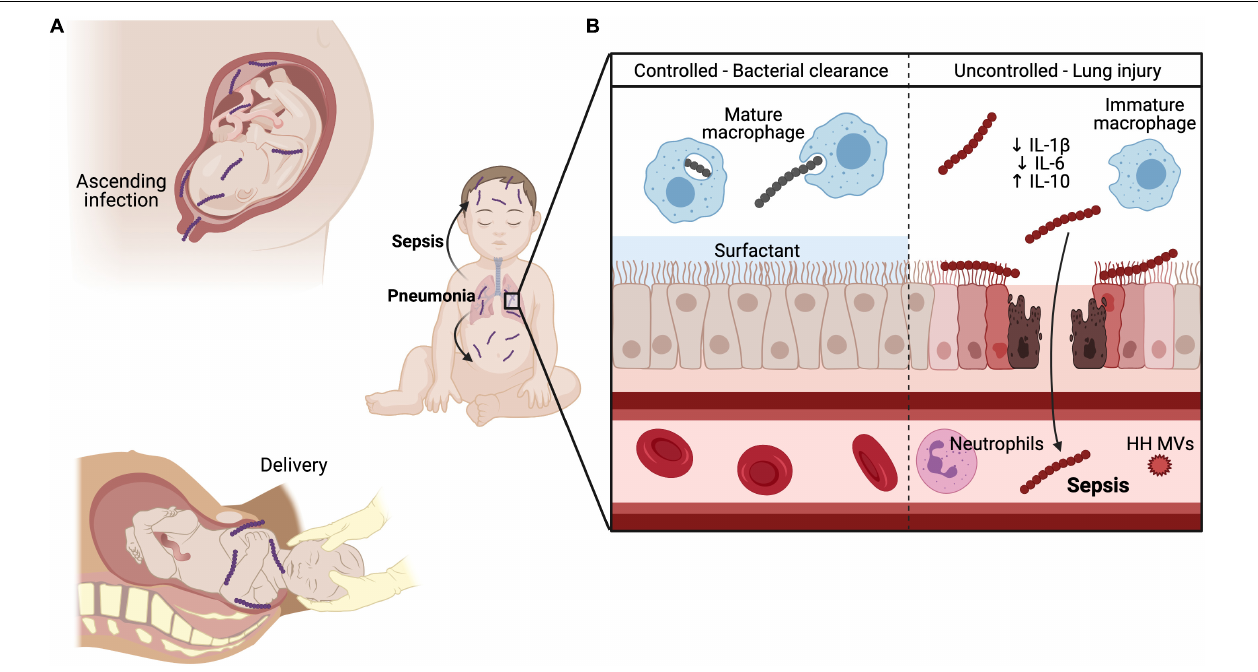
FIGURE 2 | GBS pulmonary and systemic infection in neonates. GBS can be transmitted to the developing fetus (A) through ascending infection from the maternal vaginal tract and crossing of the maternal-fetal interface or through aspiration of infected vaginal fluid during delivery. (B) In healthy adult lungs, GBS is readily phagocytosed and killed by mature macrophages through Sn recognition of GBS CPS. Additionally, lung surfactant promotes efficient gas exchange and inhibits the action of hemolysin, thereby protecting and maintaining the lung barrier. Conversely, the developing neonate has several maturational deficiencies that contribute to susceptibility to invasive GBS infection. CPS engagement with Siglec-E blunts innate immune responses by immature alveolar macrophages through reduced IL-1 β and IL-6 production and elevated IL-10 levels. Hemolysin penetrates lung epithelium and endothelium through direct cytolytic injury and promotes